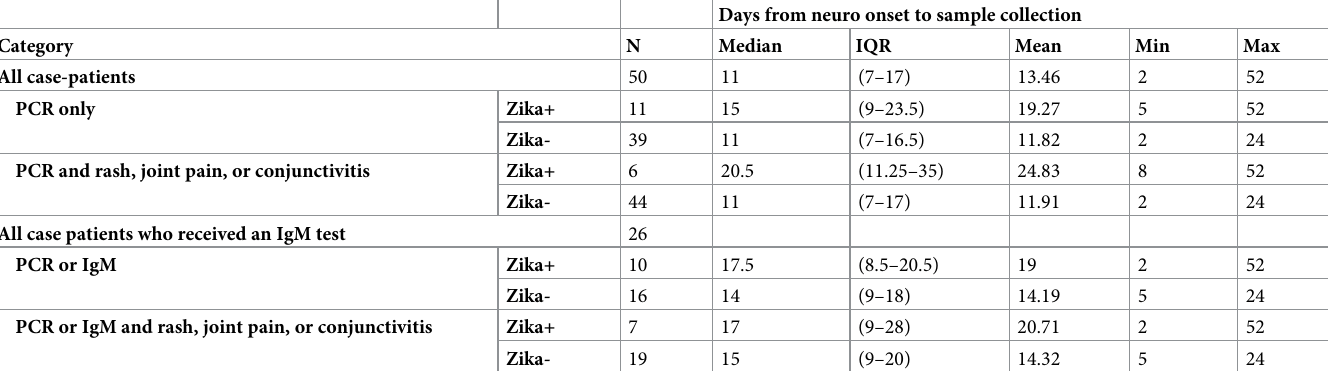
Table 3. Time (days) from neurological symptom onset to sample collection from 50 case-patients by Zika status.